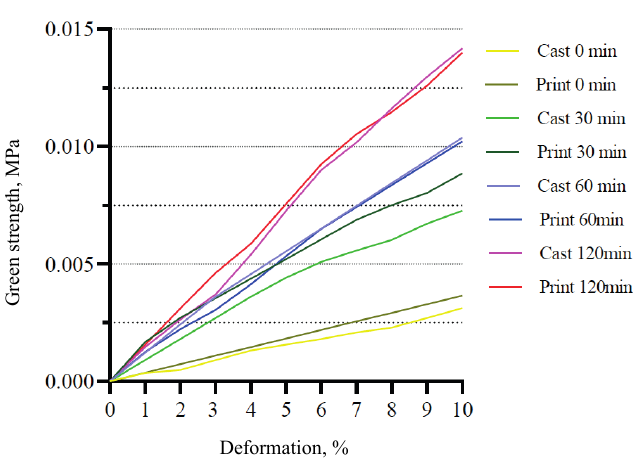
Fig. 3. Green strength of hempcrete cast and 3D printed samples at different times since